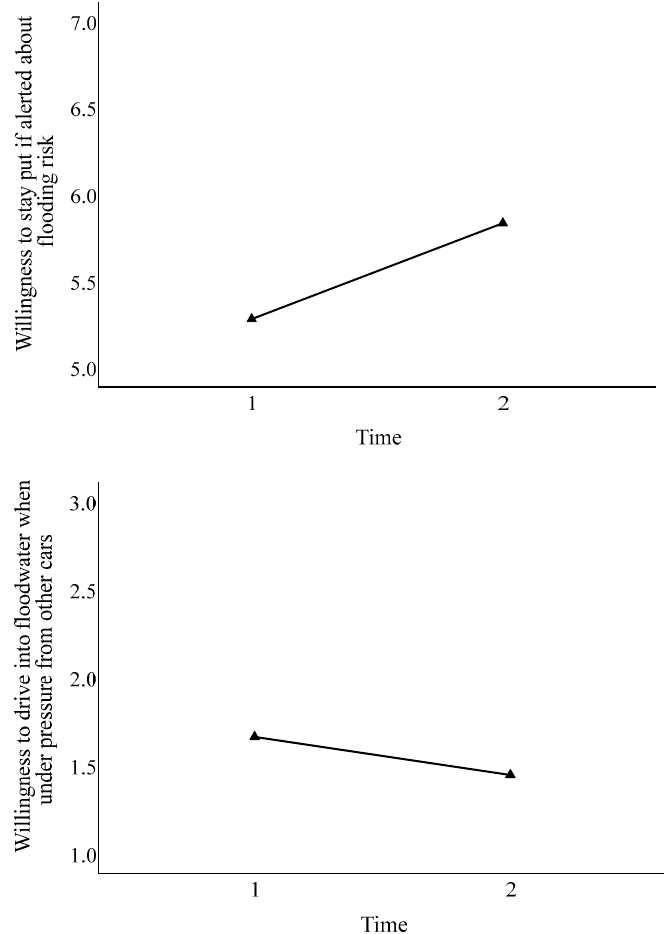
Figure 2. Changes in willingness to drive into floodwater across the three driving scenarios after a brief planning